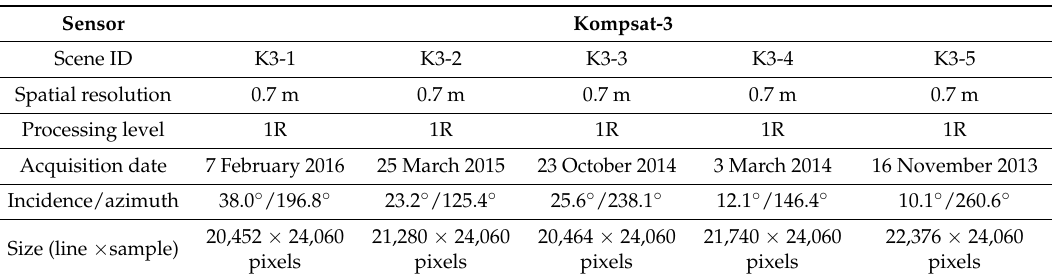
Table 1. Specifications of tested Kompsat-3 images.